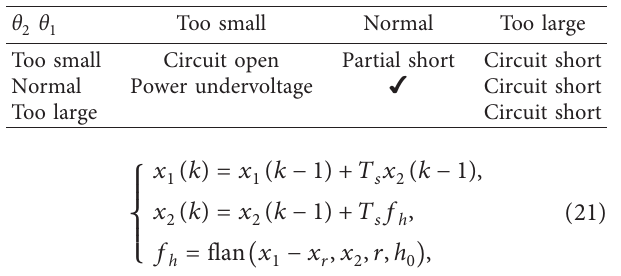
Figure 8: Parameters estimation results. Table 2: Failure